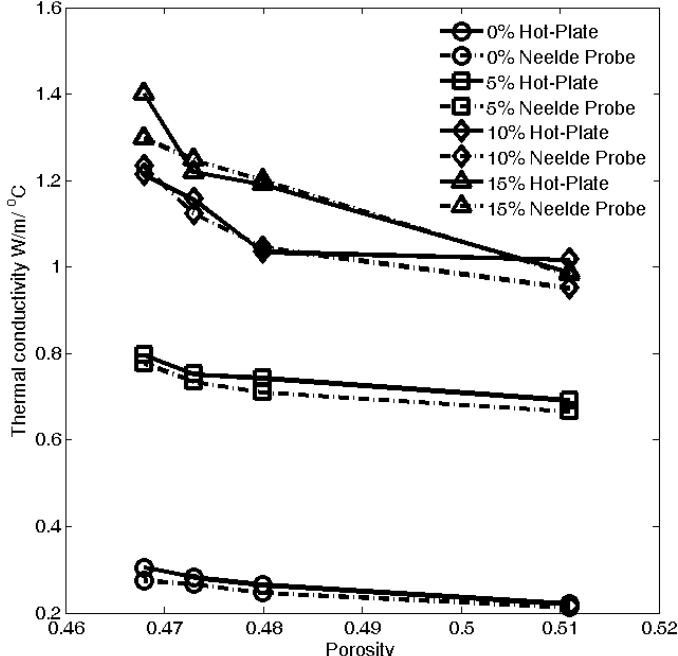
Figure 5. The thermal conductivity vs. porosity at different water contents.